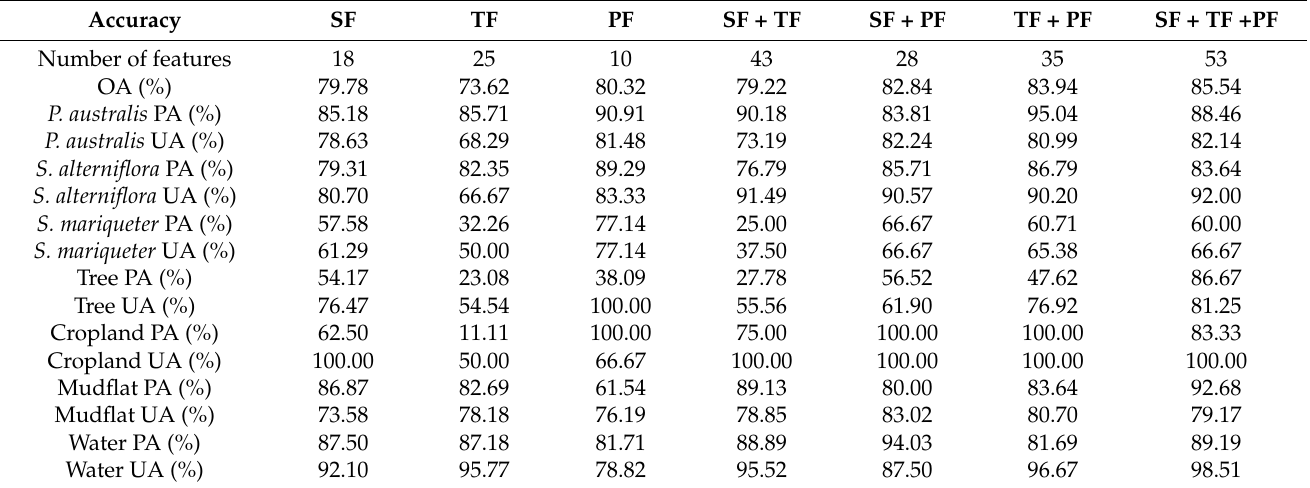
Table 4. Classifications under three kinds of features and their